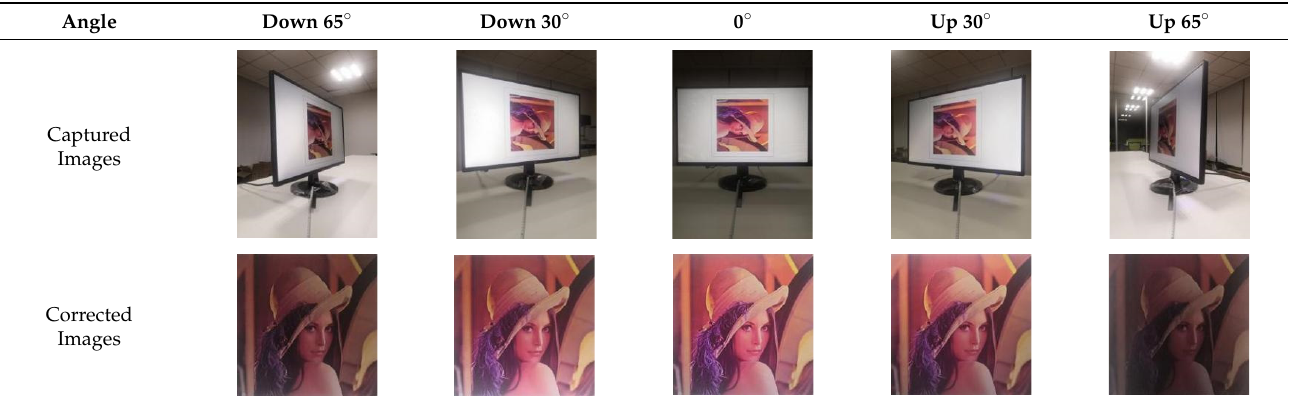
Table 8. Captured and corrected images at different vertical angles.